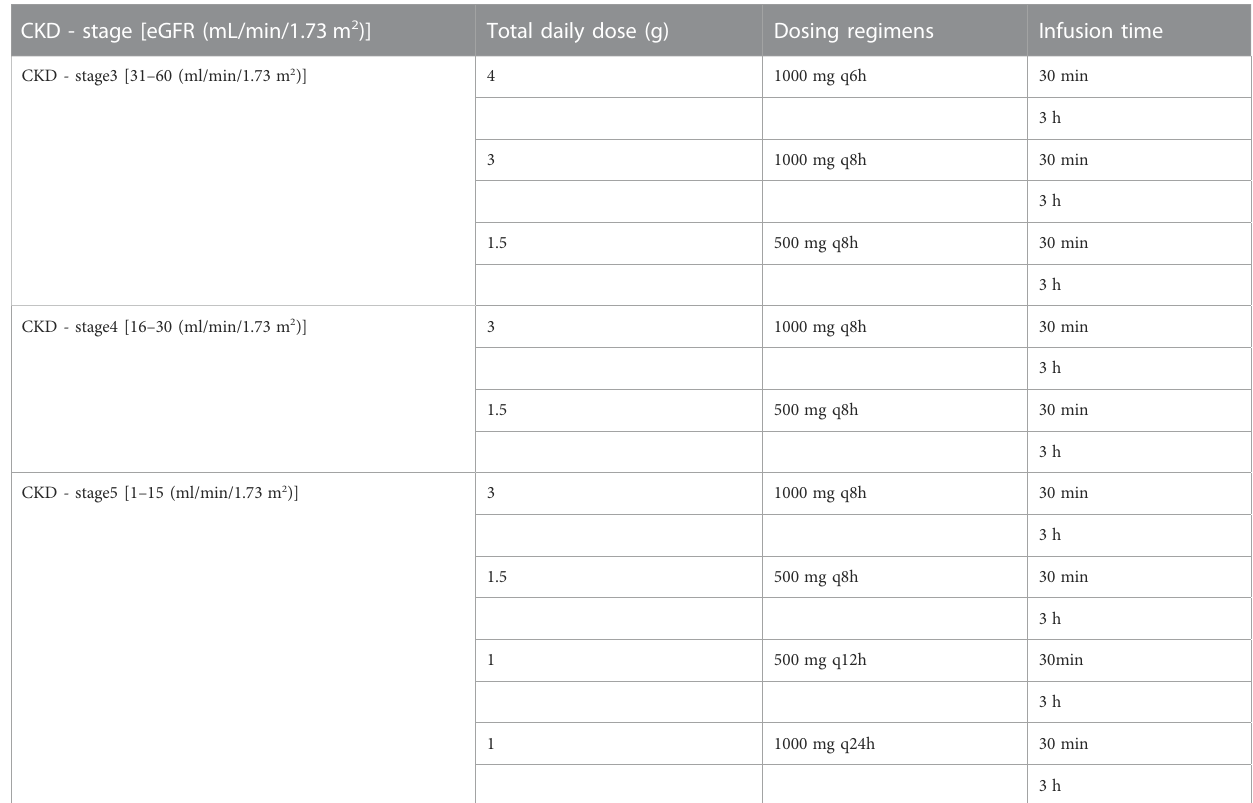
TABLE 1 Simulated dosing regimens in different CKD